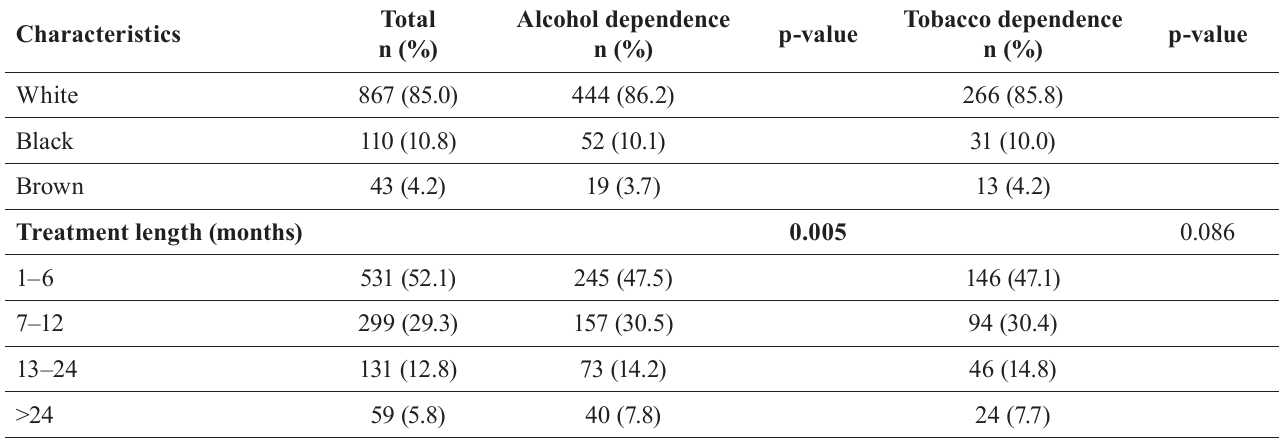
TABLE I - C haracteristics of surveyed subjects regarding alcohol and tobacco dependence and its association with demographic and clinical